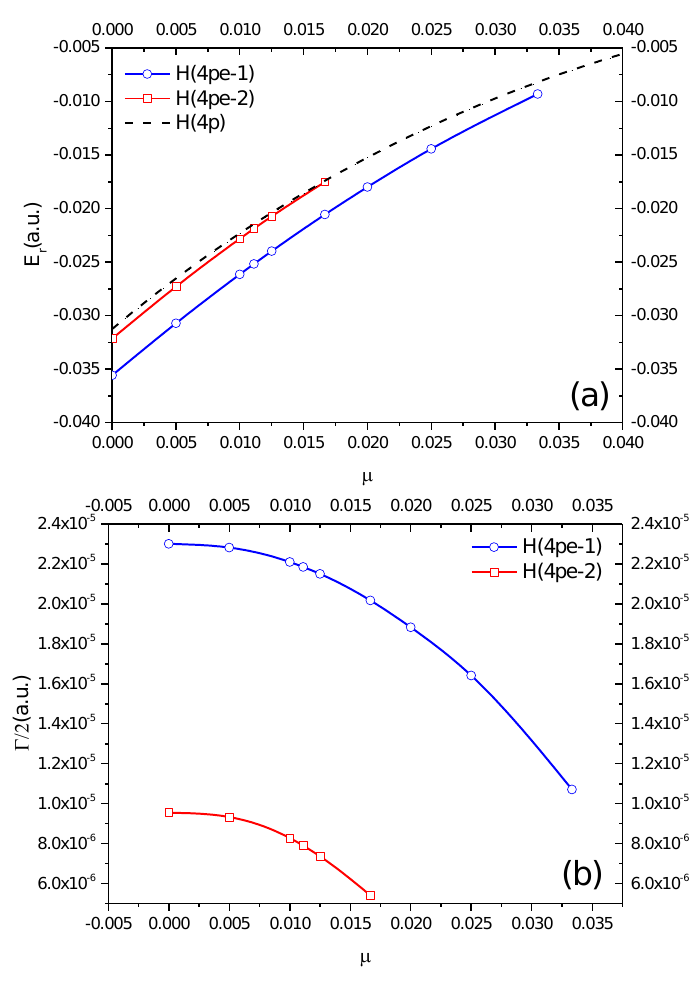
Figure 7. P -wave states with unnatural parity: ( a ) resonance energy and ( b ) half-width for the H(4p e - k ) states with k = 1, 2 as a function of μ = 1/ D .